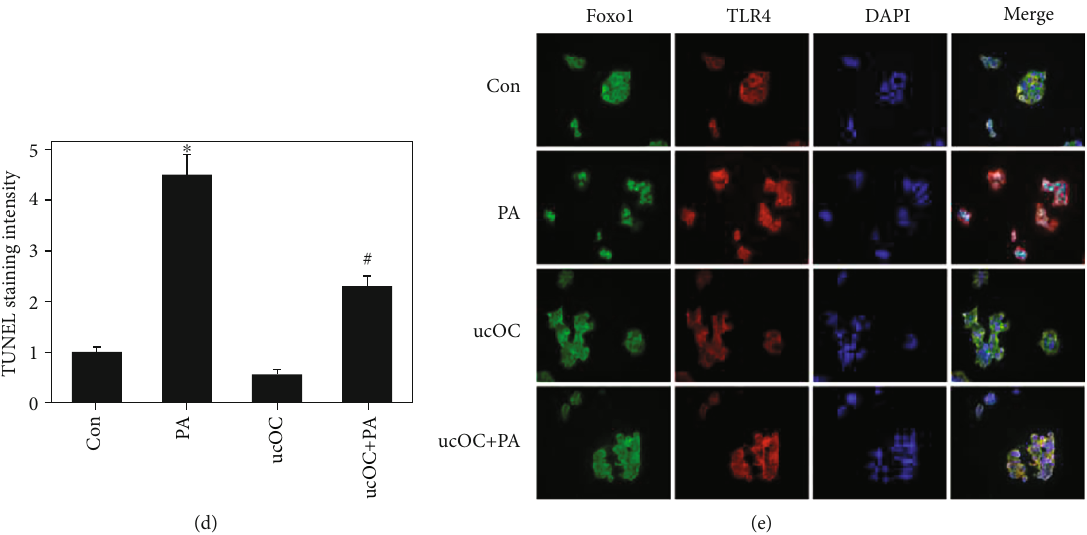
Figure 7: ucOC suppressed the apoptosis of islet β -cell and regulated FOXO1 nuclear transfer. (a) The cell apoptosis was measured after treatment with PA or ucOC. (b) The cell apoptosis was analyzed. (c) The cell apoptosis was measured with TUNEL staining. (d) The cell apoptosis was analyzed. (e) The FOXO1 nuclear transfer and TLR4 expression were measured after treatment with PA or ucOC. Beta-TC6 was used in these